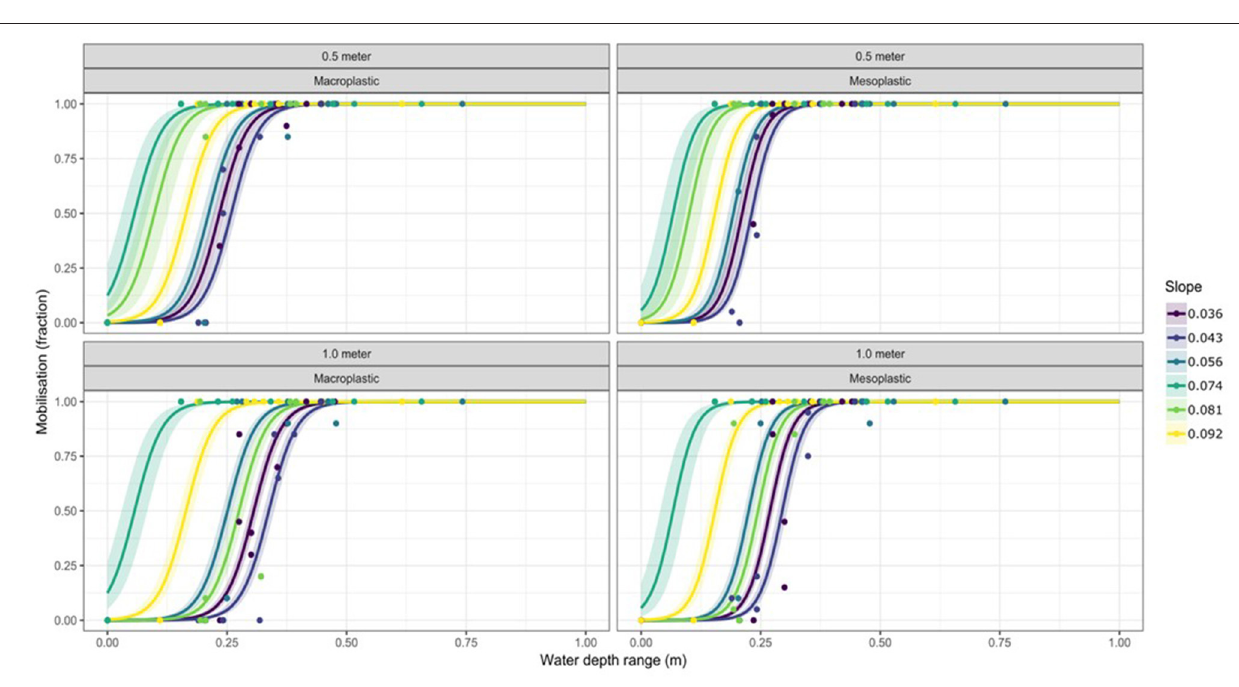
FIGURE 3 | Generalized linear model output with the fraction of plastics mobilized from the shore to the water as a function of the water depth (0–1m), different plastic types (microplastic, macroplastic), distances to water (0.5 and 1 meter) and slopes (0.036–0.092). Contours depict the 95%